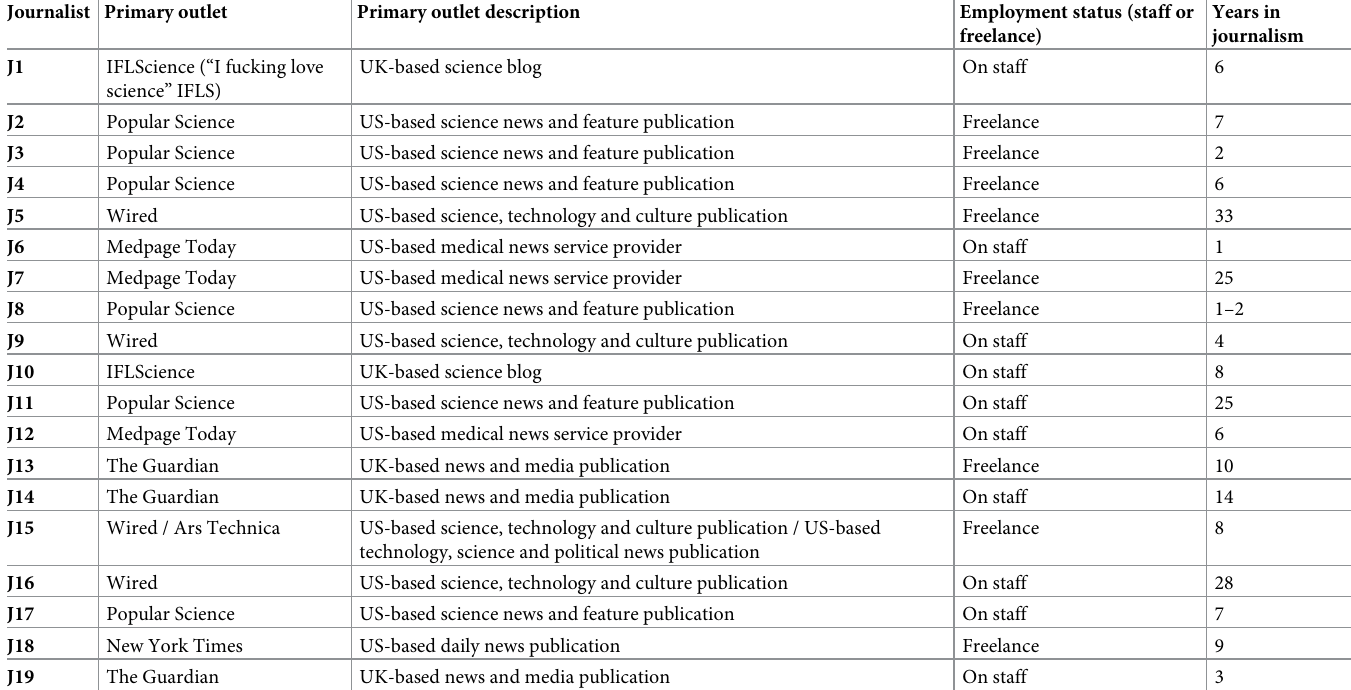
Table 2. Characteristics of journalists who participated in interviews (n = 19) about use of preprints. Journalist Primary outlet Primary outlet